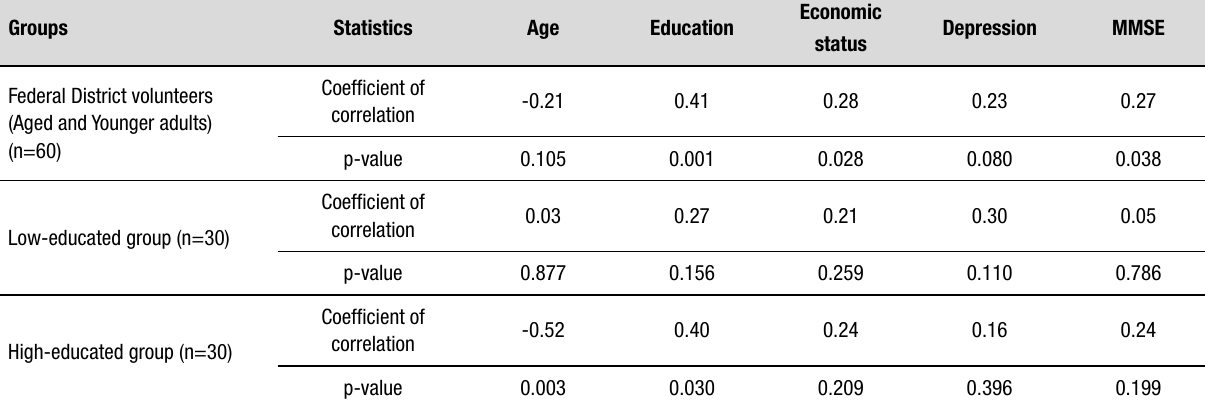
Table 3. Correlation between verbal agility performance of Federal District volunteers and sociodemographic variables.